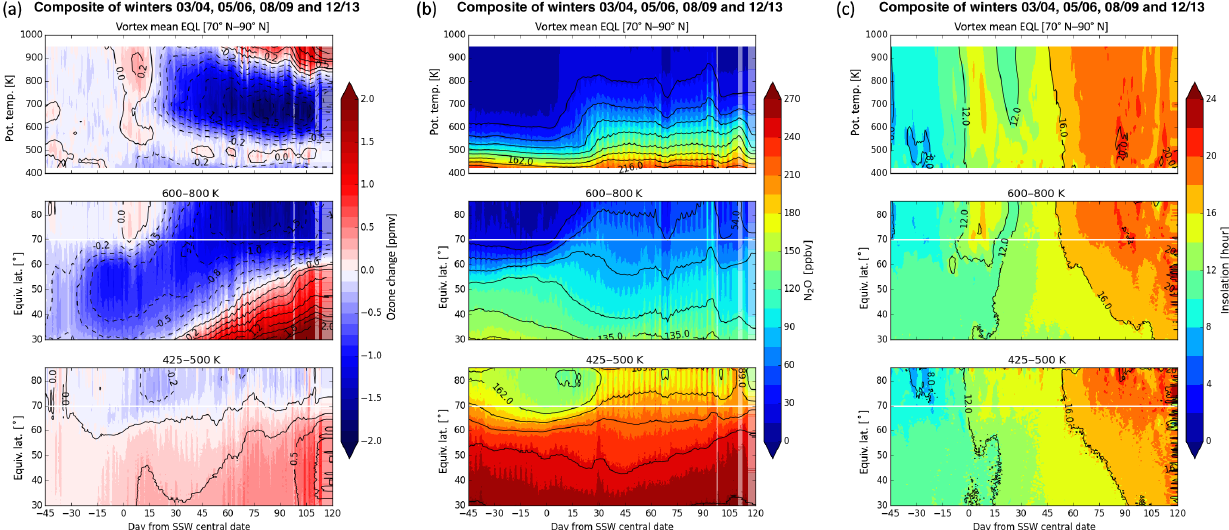
Figure 4. Same as Fig. 2 for the composite of the Arctic winters 2003/04, 2005/06, 2008/09 and 2012/13, affected by a mid-winter major sudden stratospheric warming. The time is expressed in days relative to SSW central